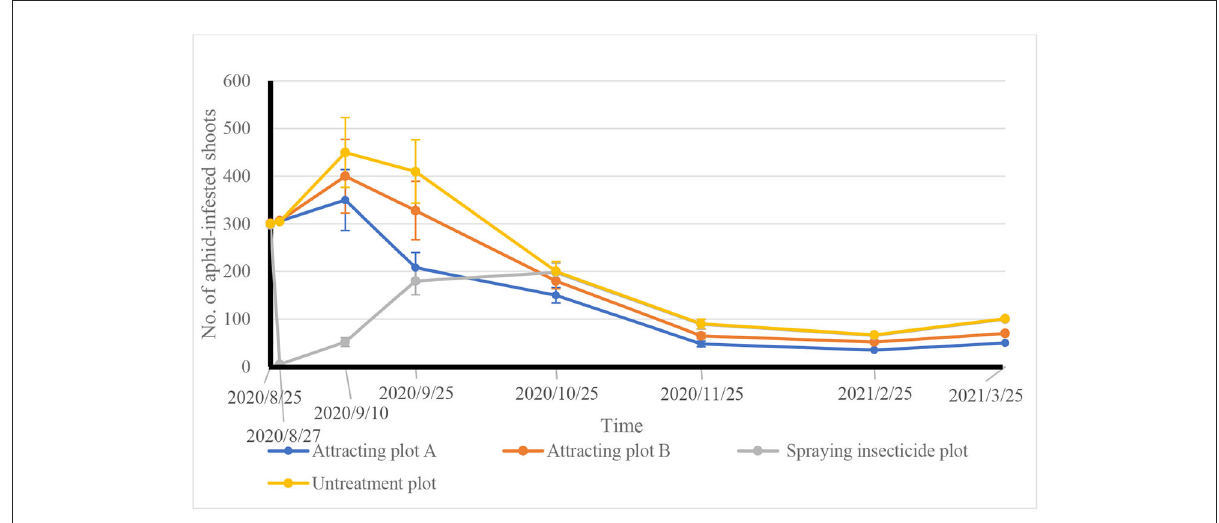
FIGURE3 Tea aphid population fluctuations within Attractant plot A and plot B, spraying pesticide plot and CK